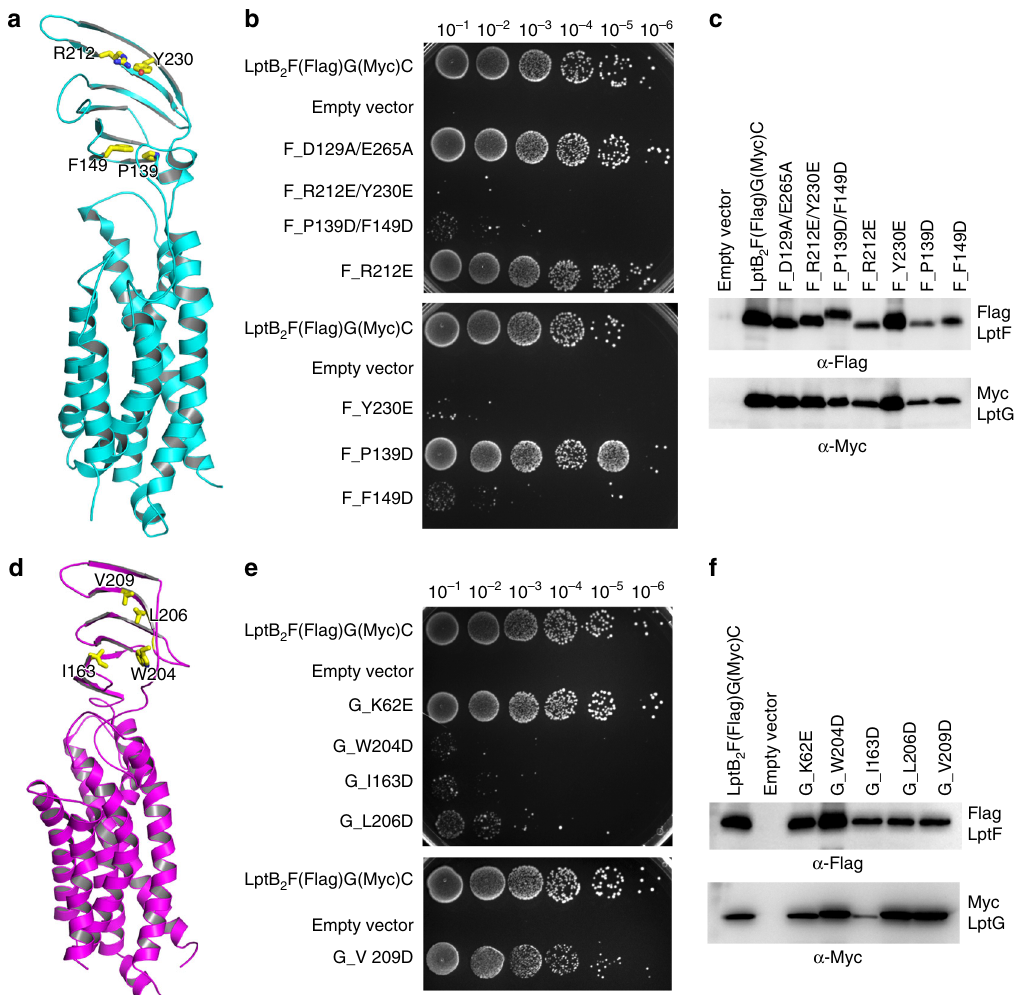
Fig. 7 Function of periplasmic domains of LptF and LptG. The structure of the β -jellyroll-like periplasmic domains of LptF and LptG is similar to that of LptC. a Cartoon representation of LptF. Hydrophobic β -jellyroll-like core residues F149, P139, Y230 and R212 are shown in stick. b Functional assays of LptF residues. Residues D129 and E265 are at the neck of the cavity as a control. Mutants R212E/Y230E, P139D/F149D, Y230E and F149D are lethal, while mutants D129A/E265A, R212E and P139D do not have any impact on cell growth. c Protein expression level of the mutants was detected by western blotting. Protein expression levels of other mutants are higher than that of P139D. Source data are provided as a Source Data fi le (7 c ). d Cartoon representation of LptG. Hydrophobic β -jellyroll-like core residues I163, W204, L206 and V209 are shown in stick. e Functional assays of LptG residues. K62 is located at the cavity as a control, and the mutant K62E grows the same as the wild type. Mutants W204D, I163D, and L206D are lethal, and mutant V209D reduces the cell growth. f Protein expression level of mutants was detected by western blotting. Protein expression level of other mutants is higher than that of mutant K62E except mutant I163D. The lethality of mutant I163D might cause by the lower protein expression. Source data are provided as a Source Data fi le (7 f